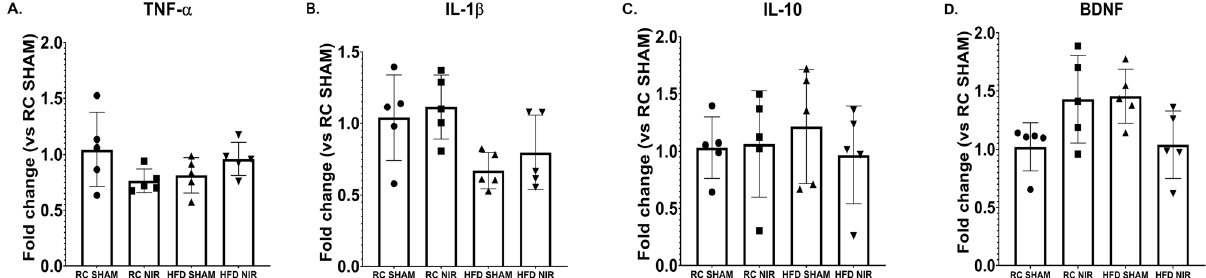
Figure 8. q-RT-PCR analyses of FCTX cytokine and BDNF levels in RC- and HFD-fed mice with or without NIR. There were no significant differences for TNF-α ( A ), IL-1β ( B ), IL-10 ( C ). or BDNF ( D ). n = 5 animals/ group; 2 replicates/animal; 2 technical replicates. Data are presented as mean ± SD. Statistical analyses: one-way ANOVA with Tukey’s post-hoc test. Graphs were created with GraphPad Prism 8.4.3 and 9.3.1 software (https:// www. graph pad. com/). Images and graphs were composed in Adobe Photoshop 22.2.0 (https:// www. adobe. com/ produ cts/ photo shopf amily.